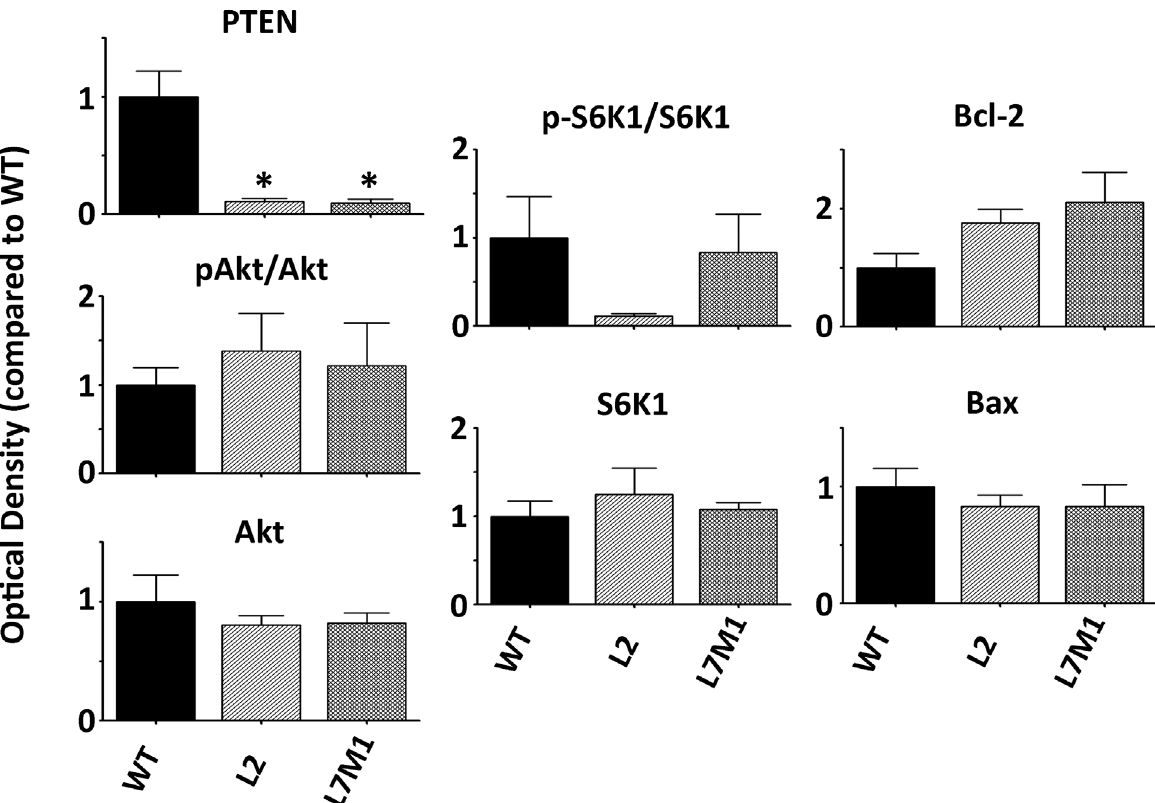
Fig 5. Protein Content in WT, L2, and L7M1 Murine Retinas before Injury. The optical density of protein content from uncrushed WT, L2, and L7M1 mouse retinas normalized to WT mice. Protein content is shown for PTEN, p-Akt/Akt, Akt, p-S6K1, S6K1, Bcl-2, and Bax. Results represent the mean ± S.E. of 4 – 9 mice/group. ( * , p (cid:1) 0.001 by one-way ANOVA with Dunnett ’ s post-test compared to WT mouse retina).